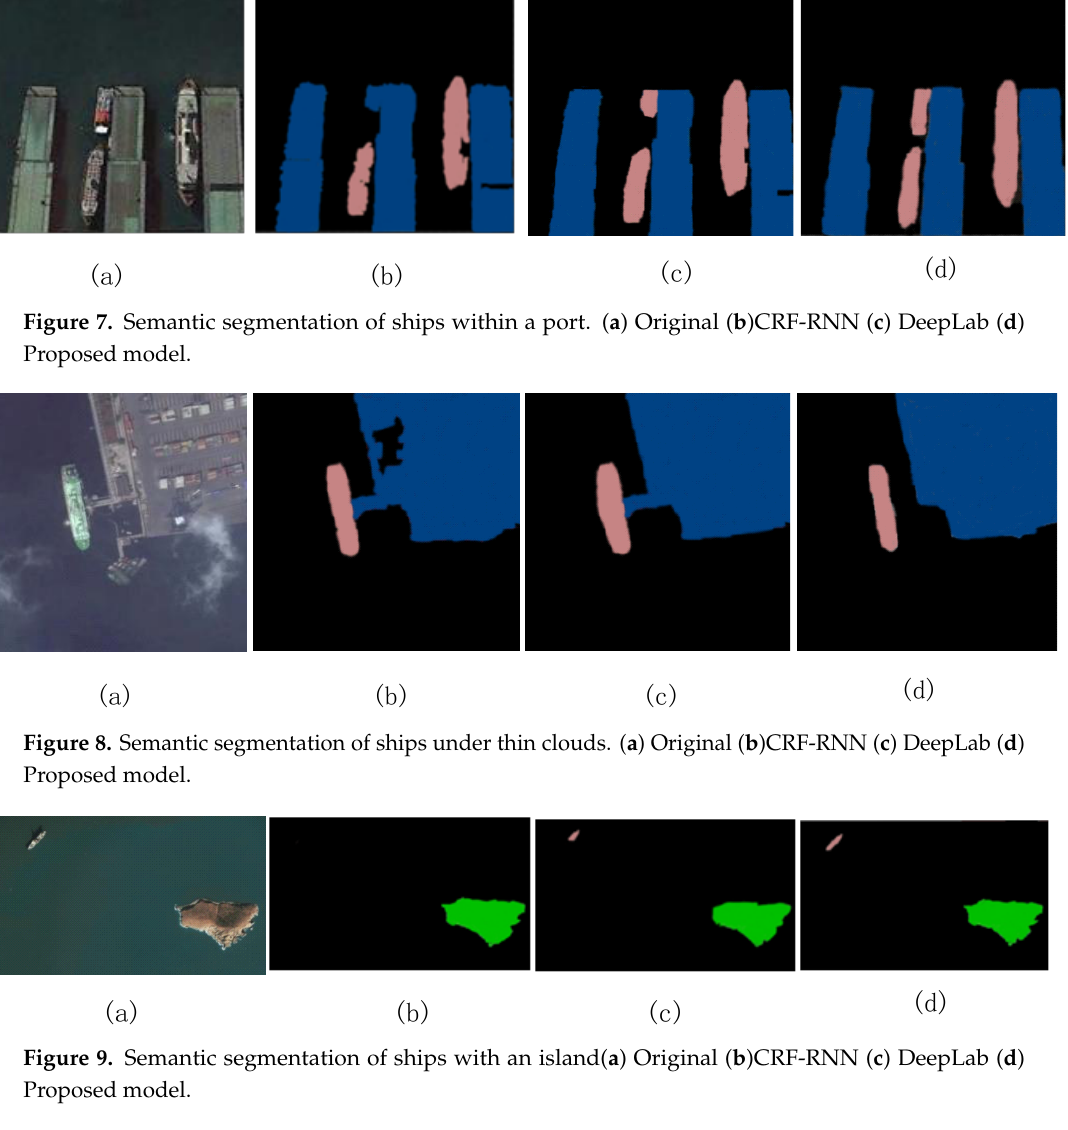
Figure 6. Semantic segmentation of ships under sea clutter. ( a ) Original ( b )CRF-RNN ( c ) DeepLab ( d ) Proposed model